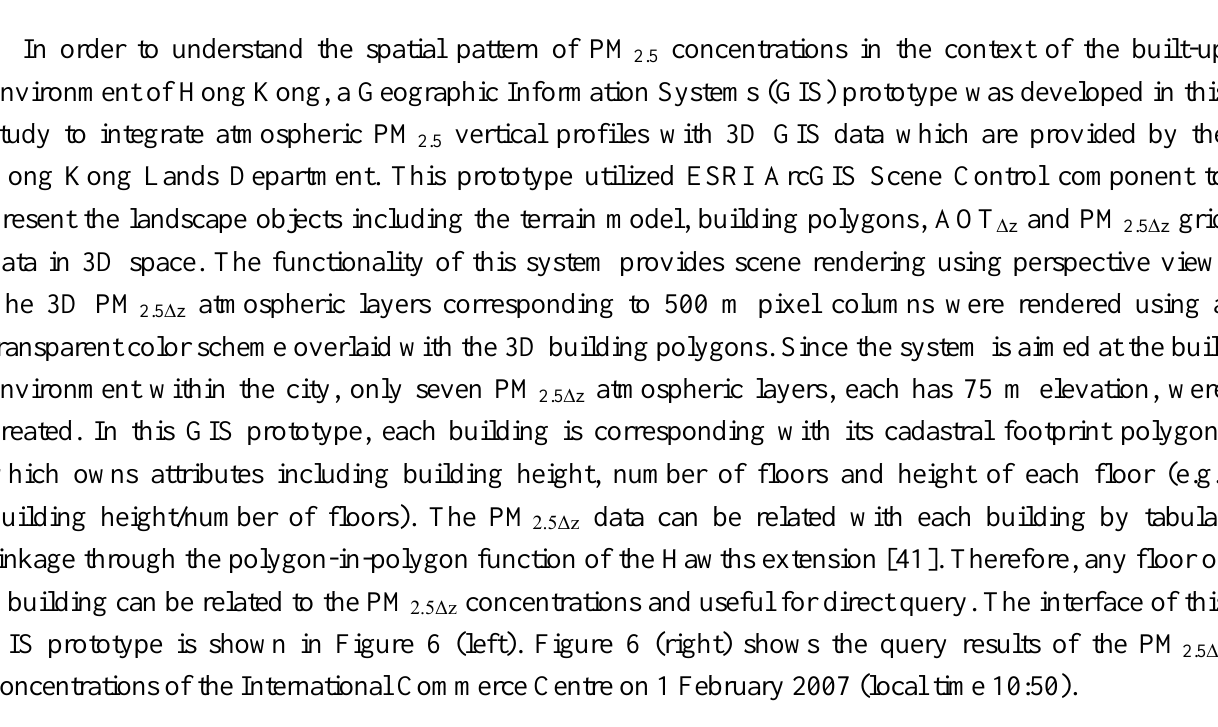
Figure 6. Screenshot of ( left ) user interface, visualizing Hong Kong with the extruded building in 3D; and ( right ) example of PM